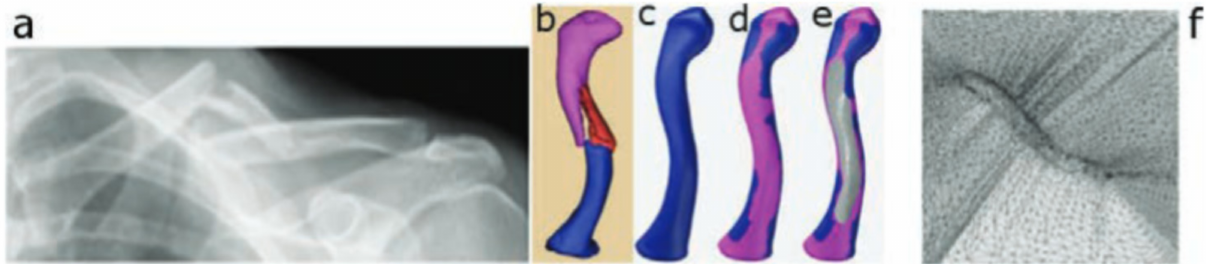
Figure 4. ( a ) Computer tomography scan of a clavicle, ( b ) 3D reconstruction, ( c ) reconstructed clavicle, ( d ) clavicle with predicted muscle attachment sites (blue area), ( e ) clavicle with designed implant and ( f ) implant embedded in extension structure (reproduced with permission from [74]; copyright © 2017 Published by Elsevier Ltd.).